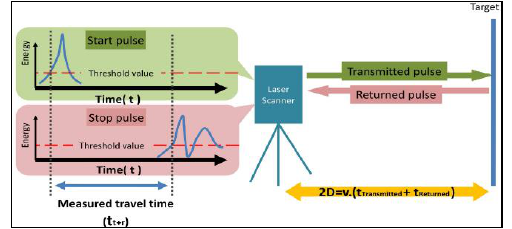
Figure 2. The basic principles of distance measurement of TLS based on TOF method (Source: Modified from Petrie and Toth,